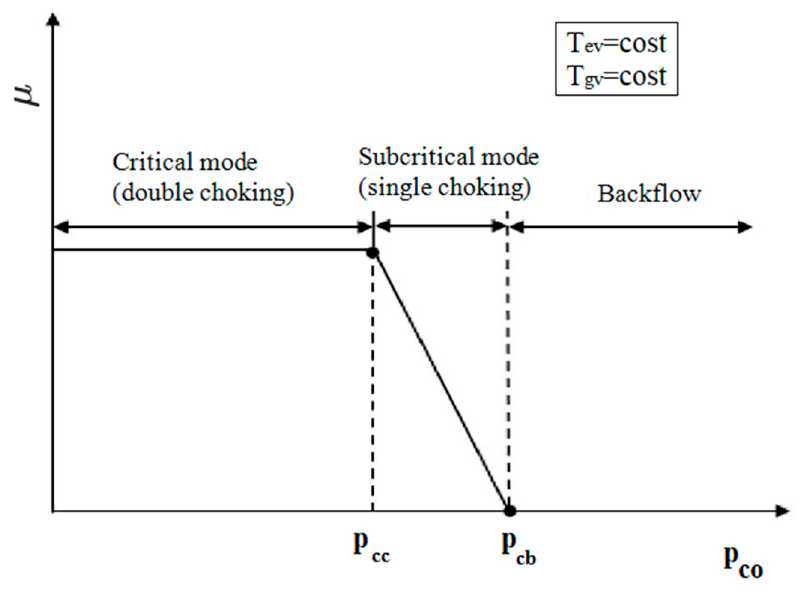
Figure 1. Operating modes of vapor ejector with fixed ejector geometry, vapor generator and evaporator temperatures.